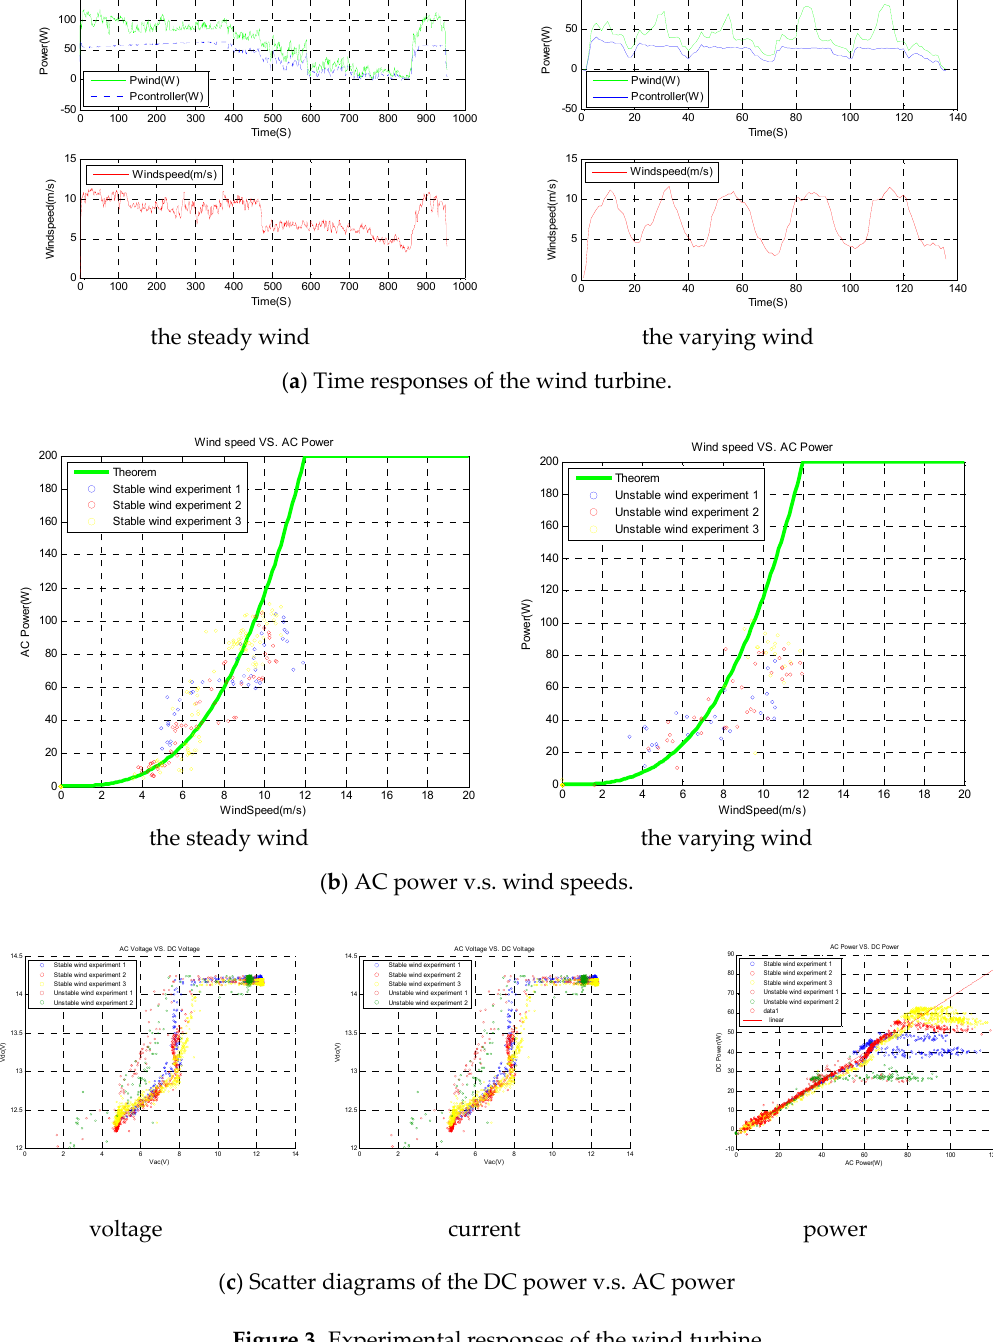
Figure 3. Experimental responses of the wind turbine.